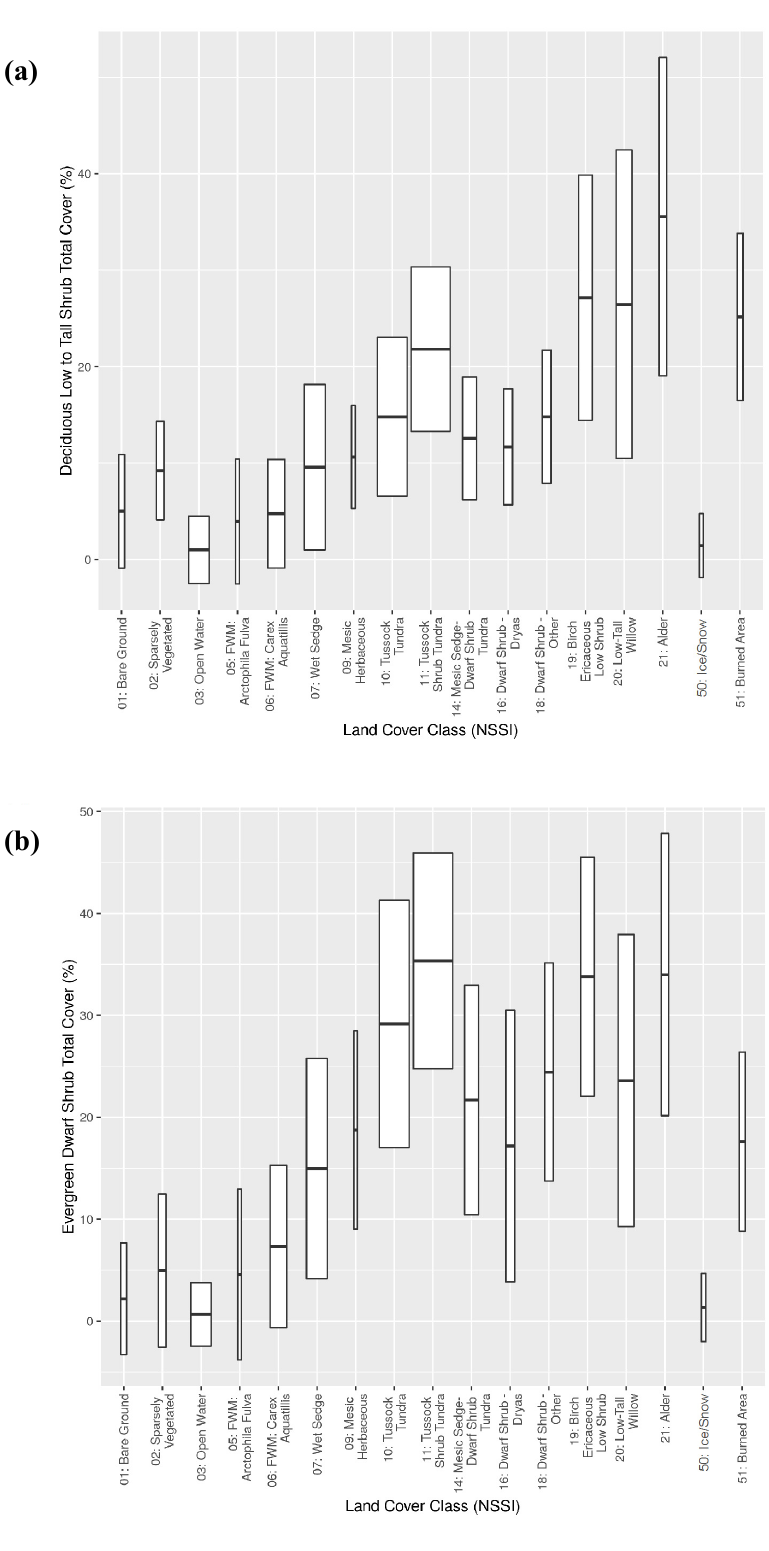
Figure 13. Box and whisker plots of ( a ) low and tall deciduous shrub cover and ( b ) dwarf evergreen shrub cover, summarized by the North Slope Science Initiative (NSSI) Land Cover [5] map class. The width of boxes is proportional to the square root of the area of each map